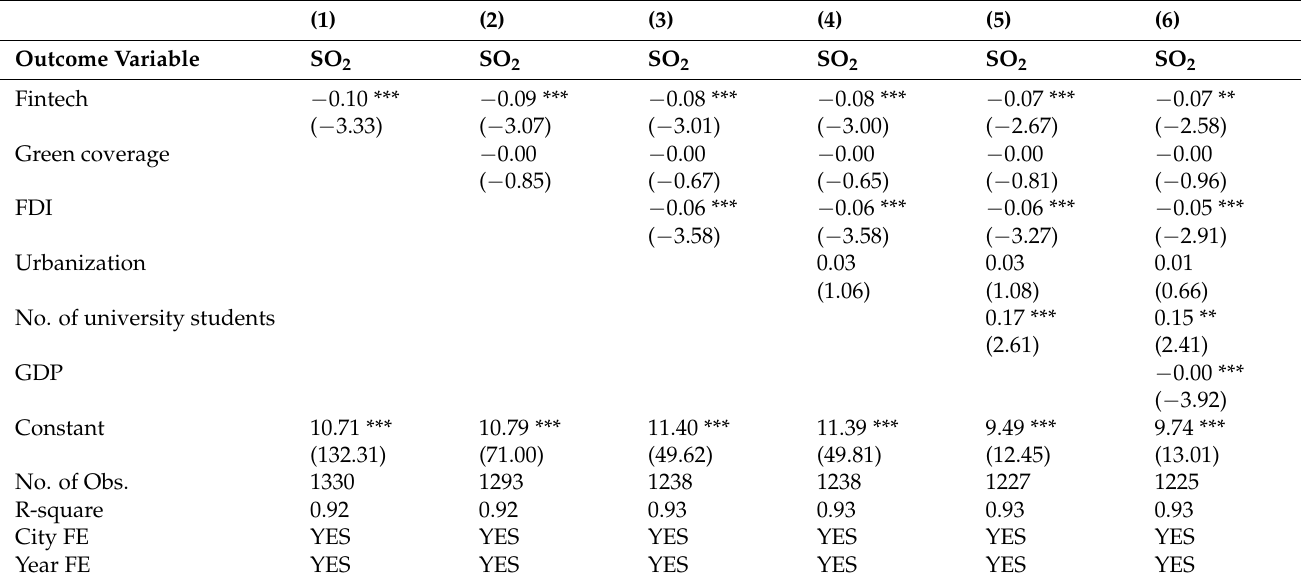
Figure 7. Dust level across cities in